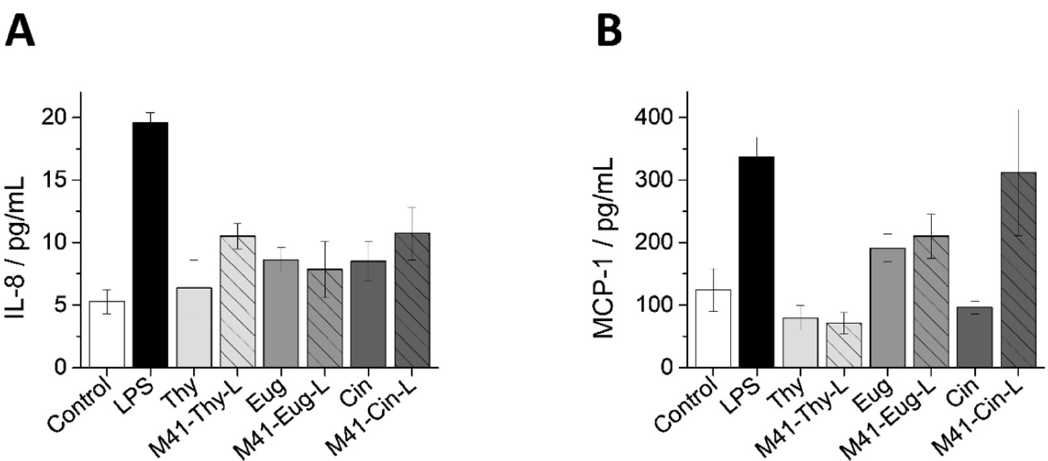
Figure 10. ( A ) IL-8 and ( B ) MCP-1 cytokine production in the apical compartment as inflammatory response of intestinal barriers exposed to the quoted treatments. Non-treated control intestinal barriers (white bar), treated with LPS as inflammatory control (black bar) and intestinal barriers after 24 h of exposure to free EOCs (solid bars) or released from M41-EOC-L (striped bars). Provided data represent the average of three different experiments measured in triplicate, and the error bars represent the standard deviation.